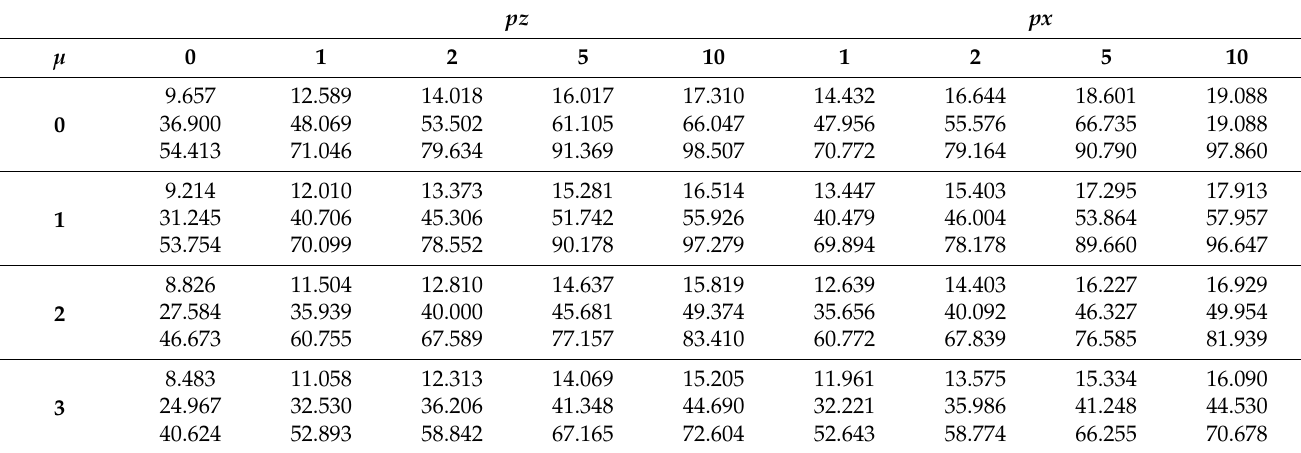
Table 6. Nondimensional first three natural frequencies ( Ω adim ) of SS FGM2-Z and FGM2-X beams. L/h = 10.